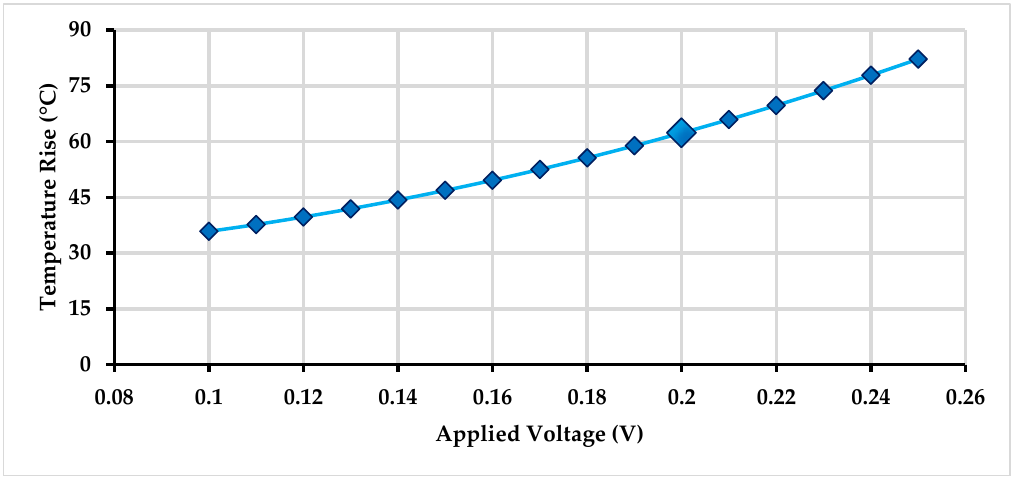
Figure 15. Temperature rise values of the electro-thermal actuator with applied voltage variations.